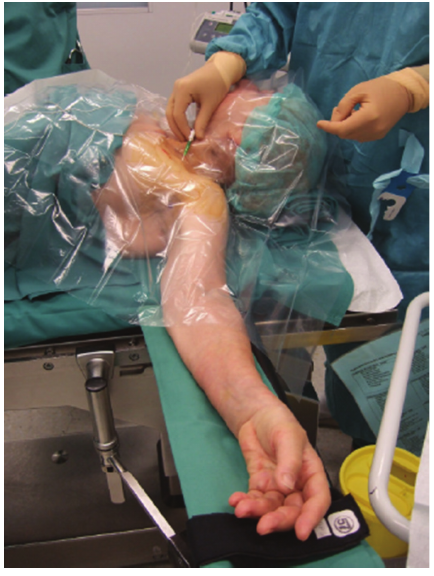
Figure 1: Sterile precautions for regional